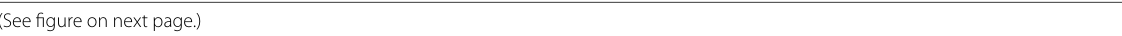
figure on next Fig. 16 Comparison between grain density, seismic velocities and impedance measured in the laboratory with corresponding physical parameters from borehole logging. Compressional velocities along horizontal (red square) and vertical (blue circle) plugs have been calculated at in-situ condition applying the velocity/pressure derivatives using empirical formula of Wepfer and Christensen (1991). The vertical acoustic impedance has been used to calculate the reflection coefficient to simulate the normal incidence of seismic waves. Error bars are within symbols. Samples of Core IV are after: a Müller and Briegel (1977), b Freund (1992), c Yan et al.